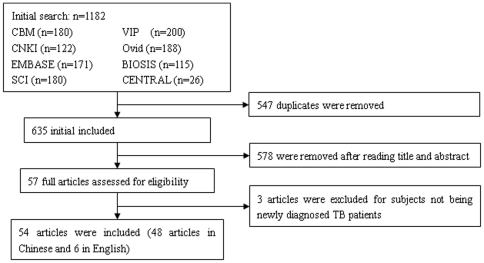
Flow diagram of study searching and selection process.